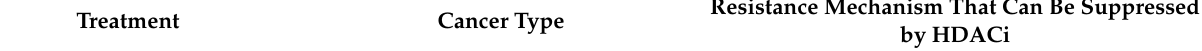
Table 2. Examples of how HDAC inhibitors can be utilized to mitigate specific resistance mechanisms in several types of treatment and cancer settings.